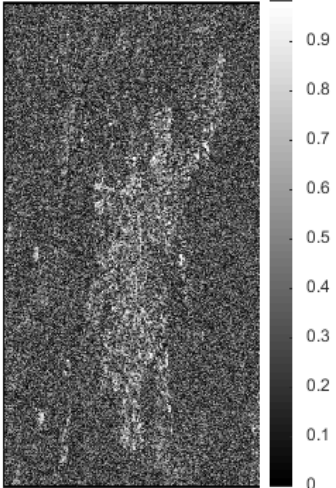
Figure 5. Mean value of the amplitude’s cross correlation index, computed across the co-registered images dataset—Buzău area .